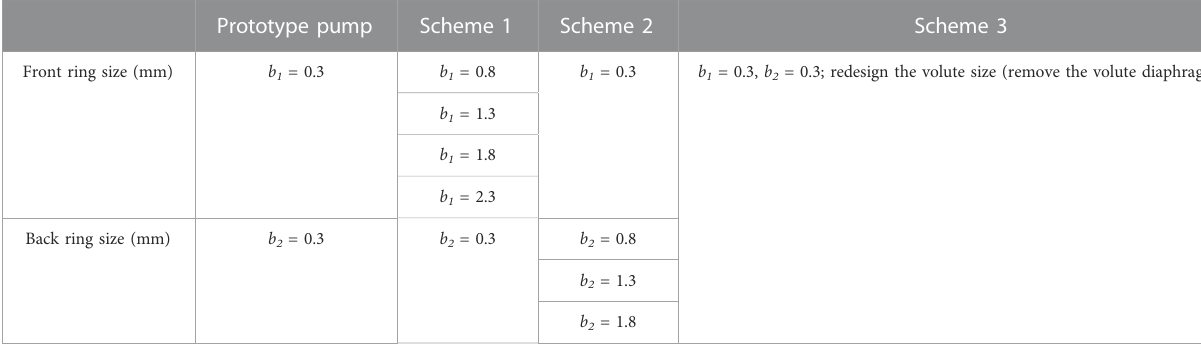
TABLE 3 Simulation grouping and related experimental